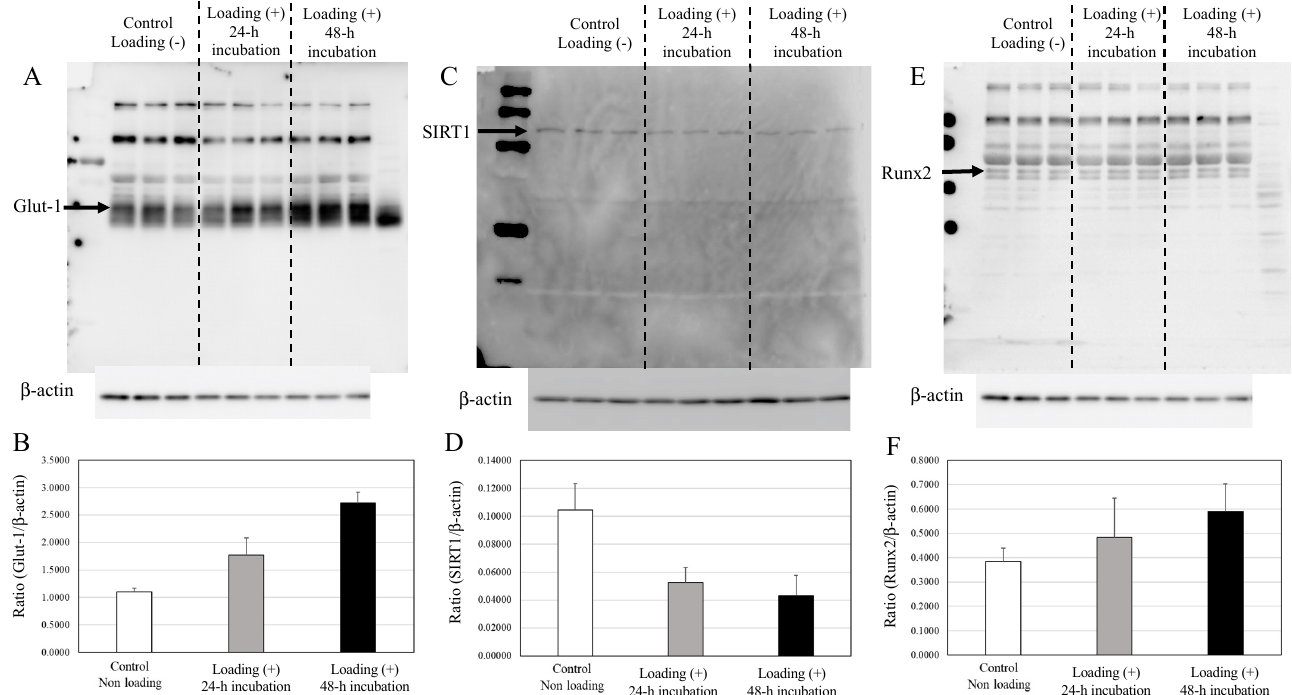
Figure 5. Expressions of Glut1, SIRT1, and Runx2 in osteoblasts. ( A ) The expression of Glut1 in non-loaded osteoblasts, 24 h loaded osteoblasts, and 48 h loaded osteoblasts. ( B ) The expression relative to β -actin. ( C ) The expression of SIRT1 in non-loaded osteoblasts, 24 h loaded osteoblasts, and 48 h loaded osteoblasts. ( D ) The expression relative to β -actin. ( E ) The expression of Runx2 in non-loaded osteoblasts, 24 h loaded osteoblasts, and 48 h loaded osteoblasts. ( F ) The expression relative to the level of β -actin.